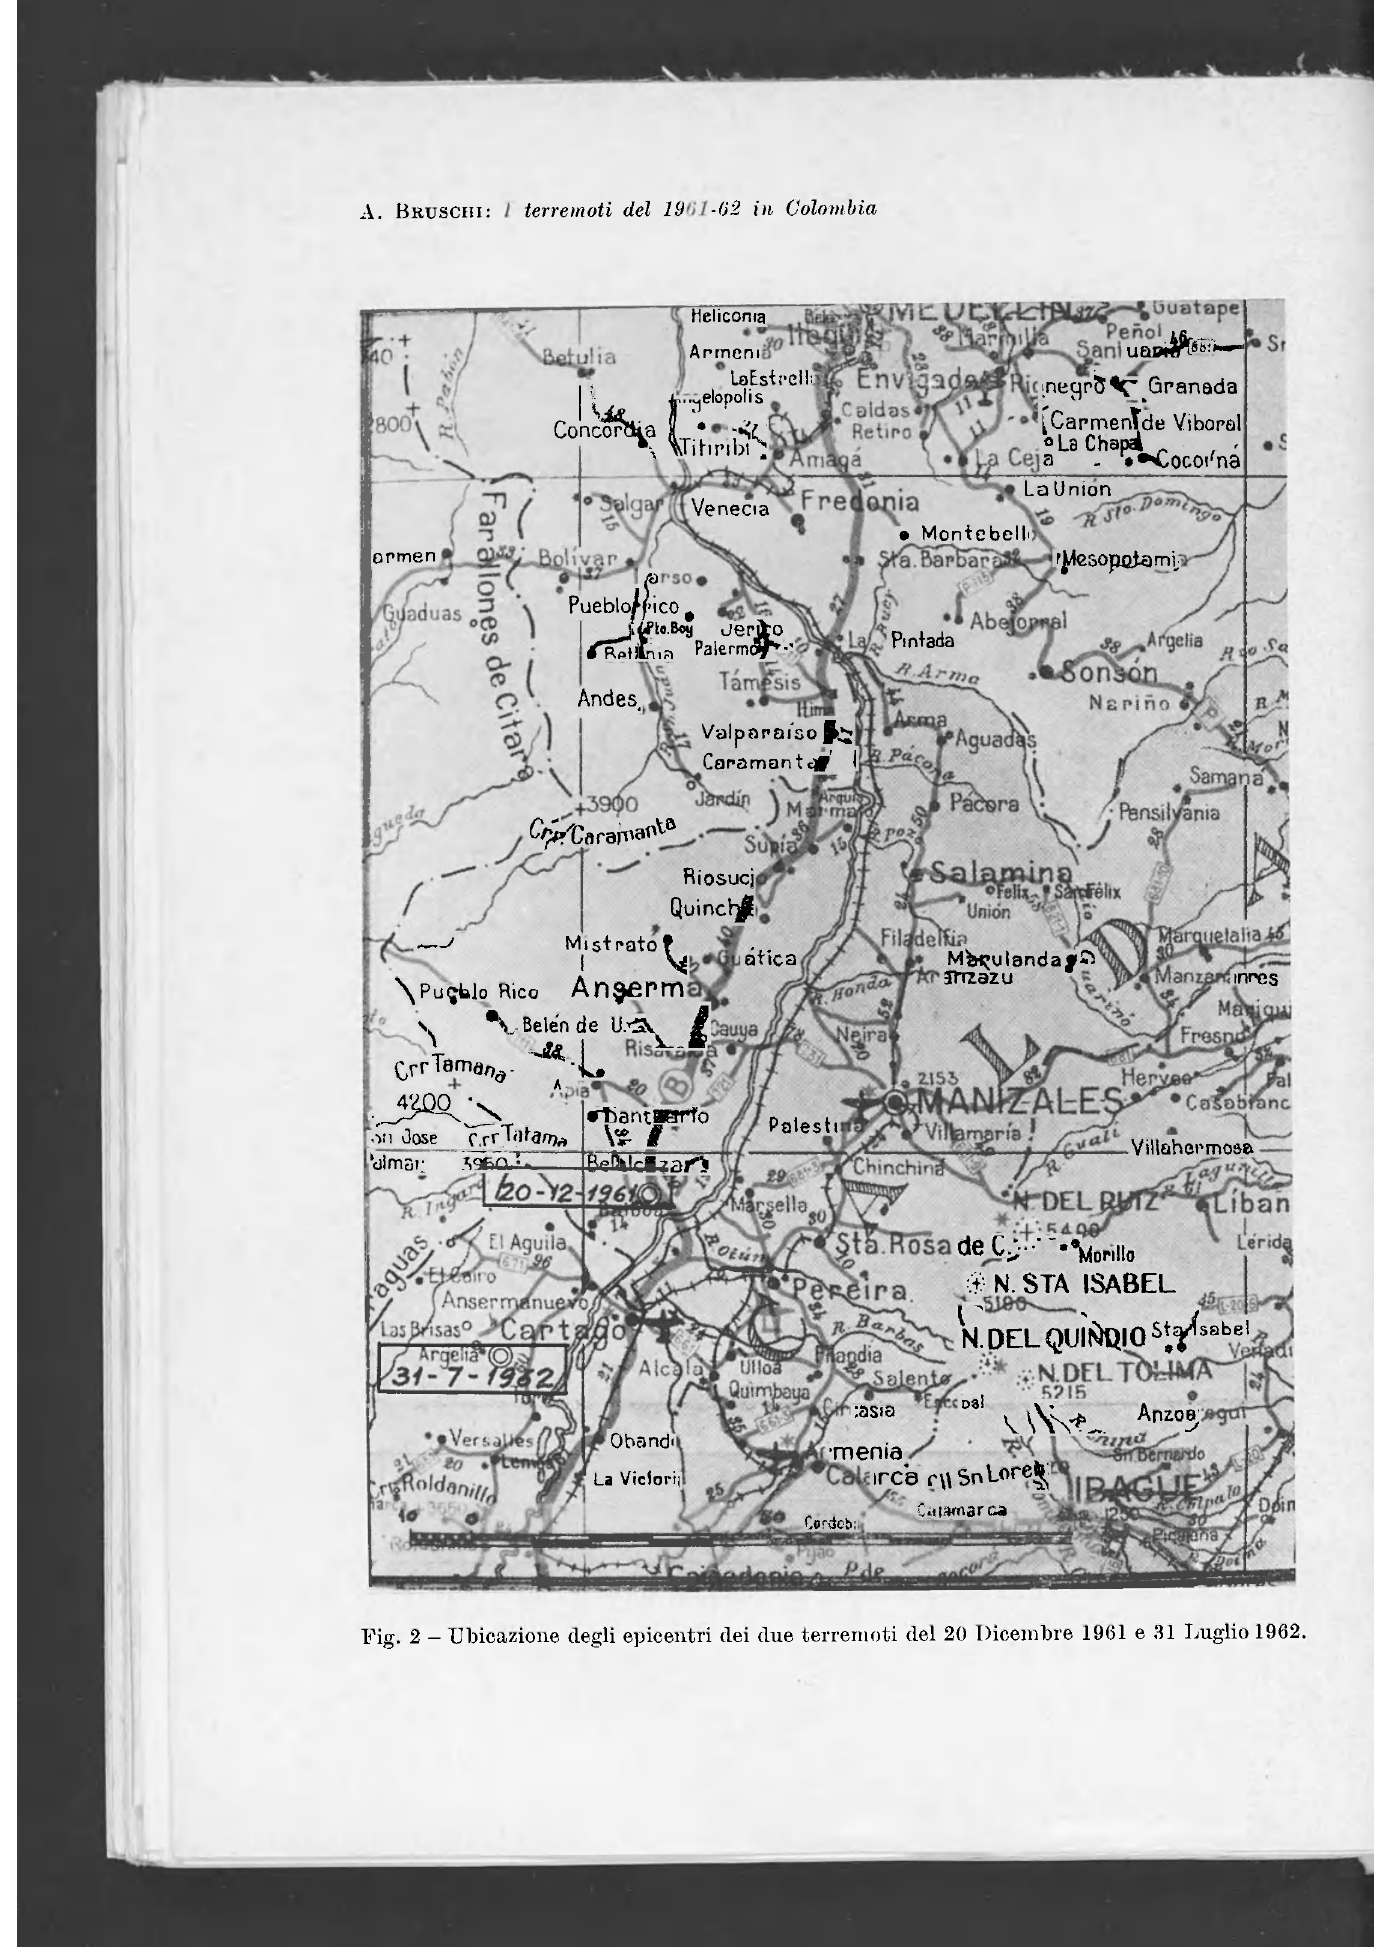
Fig. 2 - Ubicazione degli epicentri dei due terremoti del 20 Dicembre 1961 e 31 Luglio